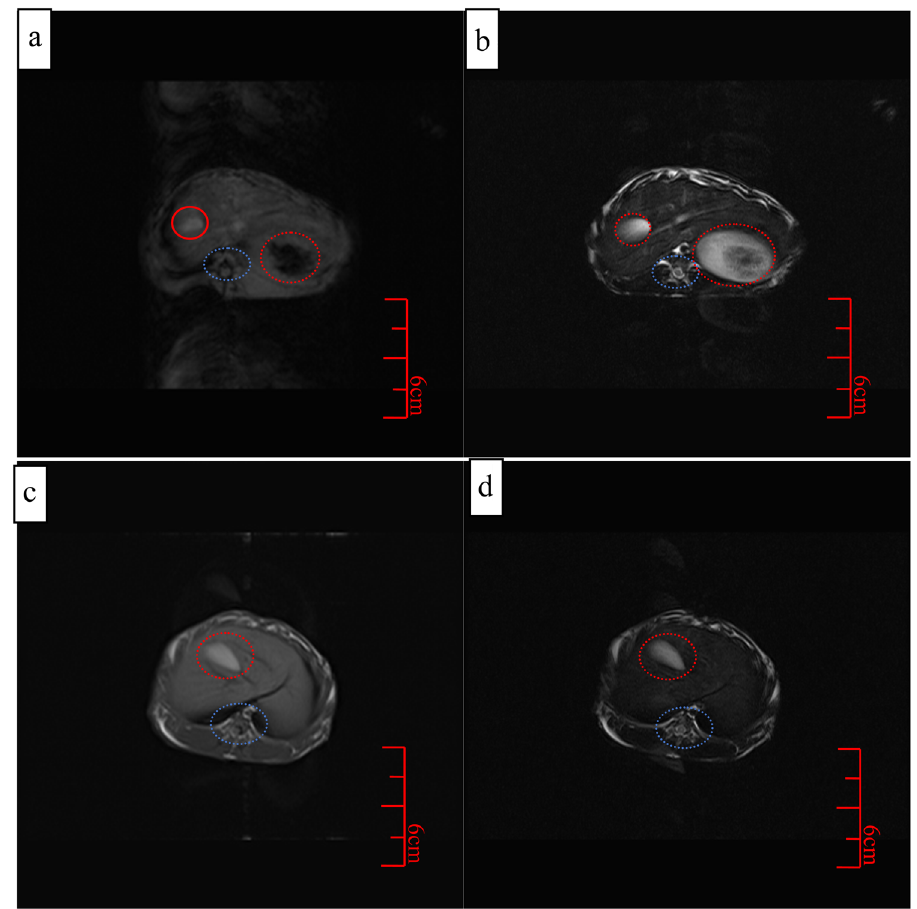
Figure 8: Simultaneous T 1 - and T 2 - weighted coronal images of Fe 3 O 4 @DDT - PMAA MFs in rabbit liver cancer, ( a ) pre - rejection for T 1 images; ( b ) after - rejection for T ( c ) pre - rejection for T ( d ) after - rejection for T 1 images; 2 images; and 2